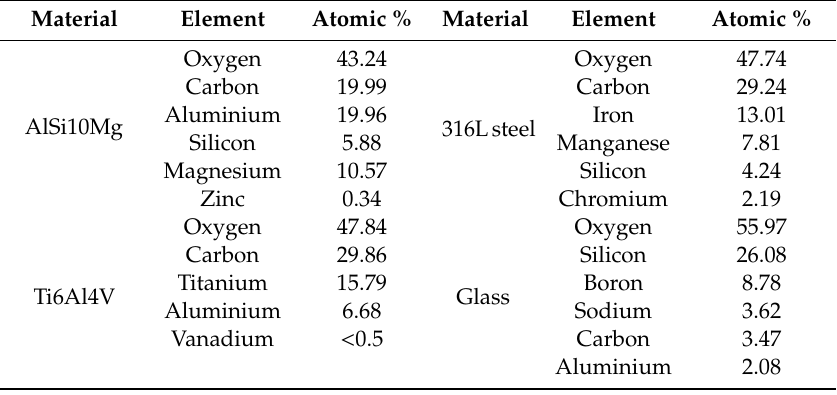
Table 5. Elemental composition of the surface of the fillers measured by XPS. Material